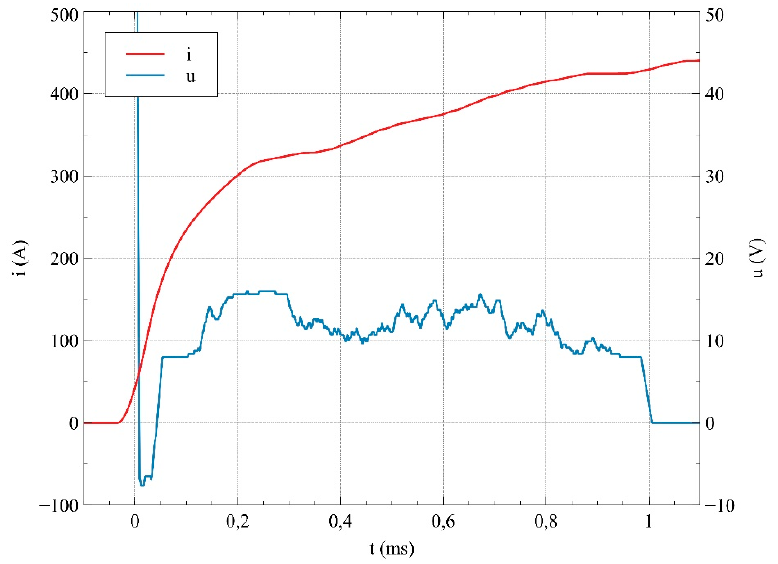
Figure 6. Current and voltage waveforms for a selected test with visible contact bounce.